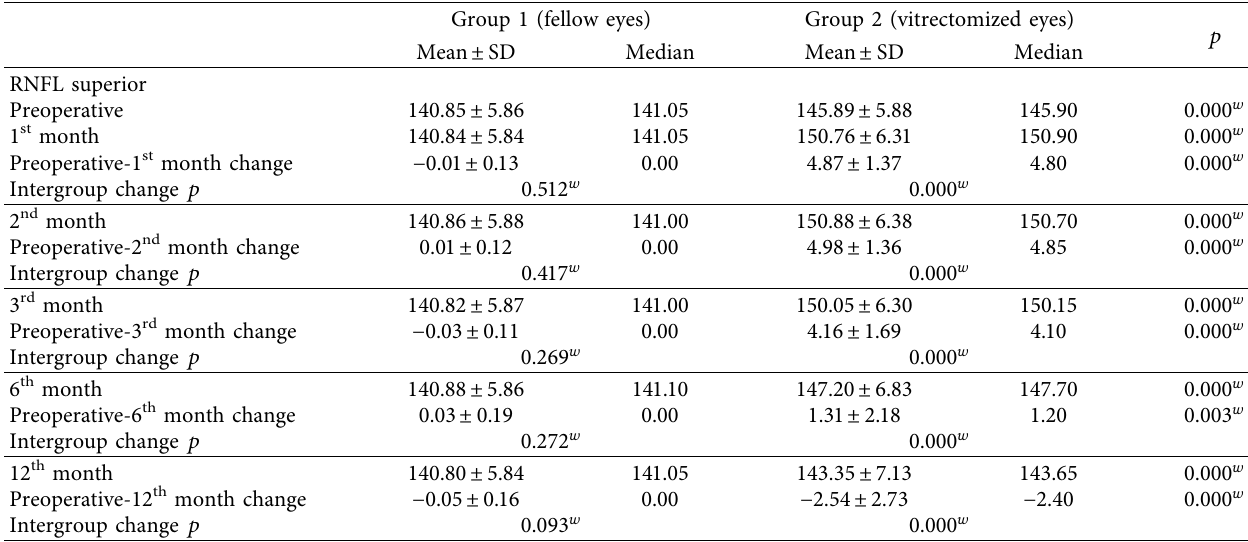
Table 1: Retinal nerve fiber layer thickness ( μ m) change in the superior quadrant of the groups.